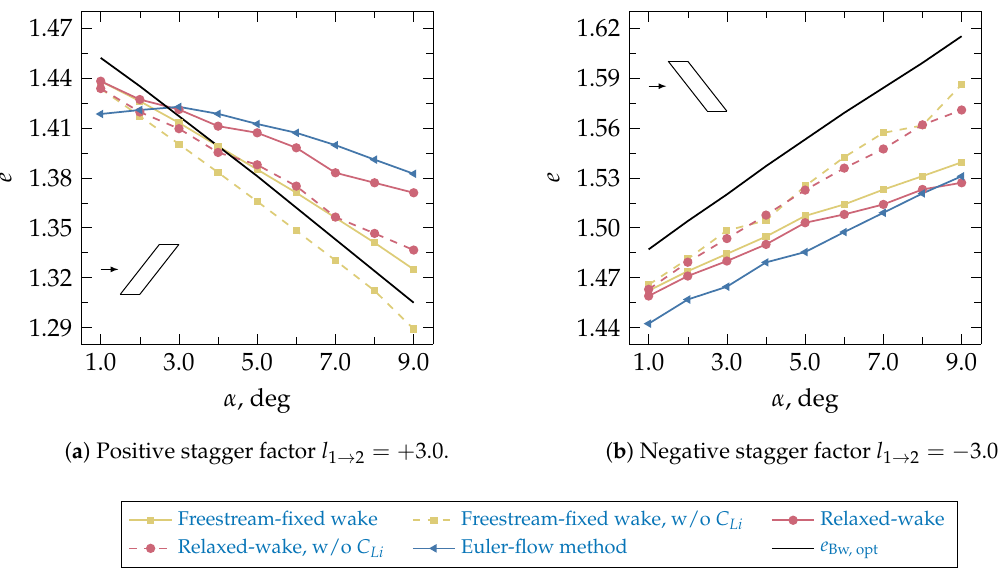
Figure 4. Computed span efficiency factor versus the freestream angle of attack α